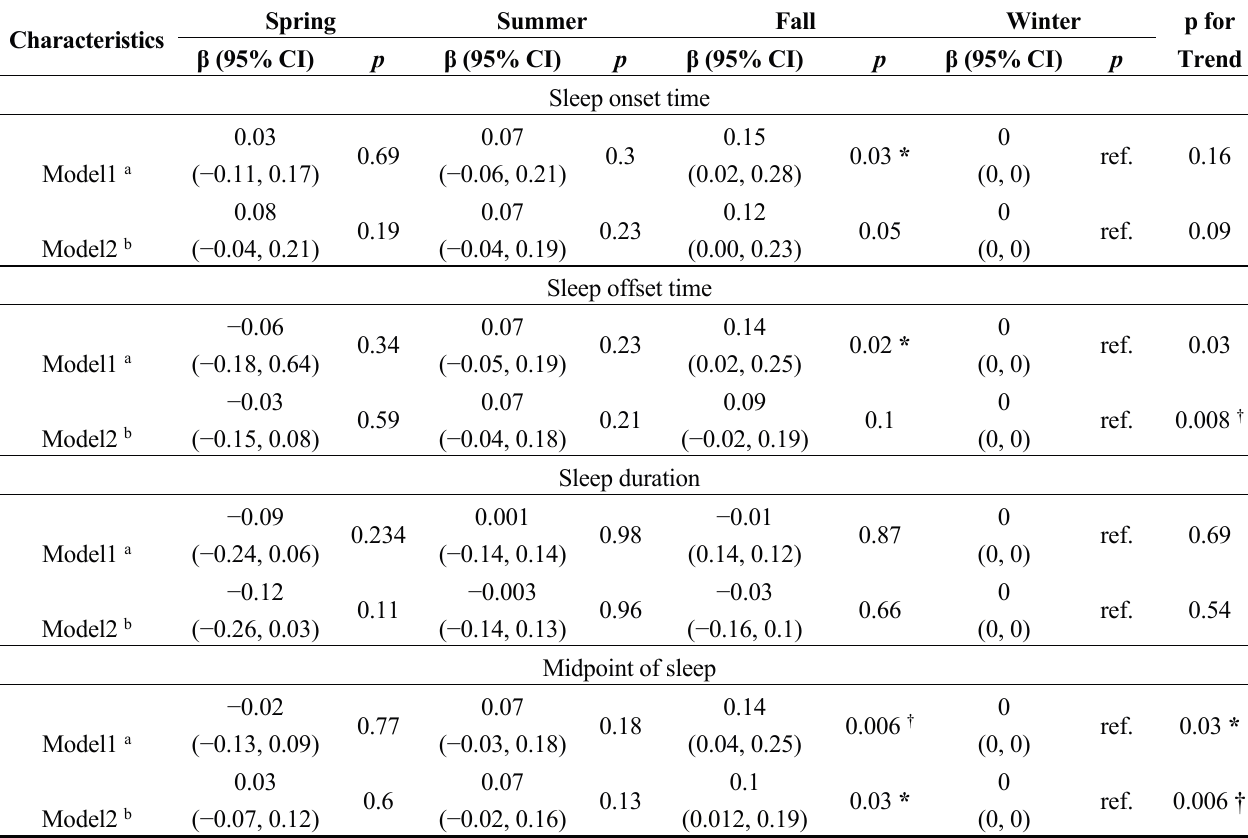
Table 4. Sleep timing preference for women by season of birth Spring Summer Fall Characteristics